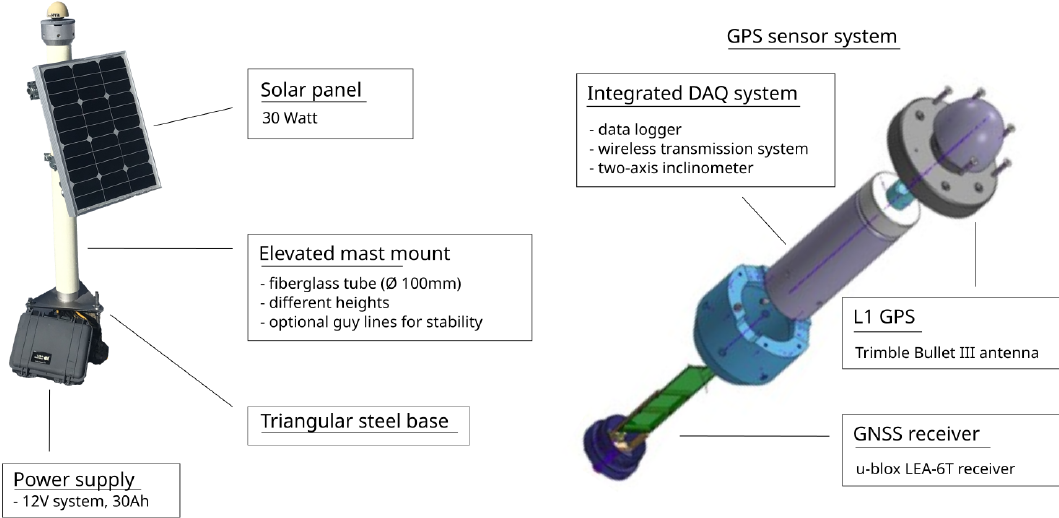
Figure 1. Structure and components of the GNSS sensor developed in the PermaSense Project. (Left) Structure of the GNSS station. (Right) Detail of the embedded GNSS antenna, data logger, and wireless transmitter. Table 1. Overview list of the sensors used, ordered by sensor type. n.a. denotes not